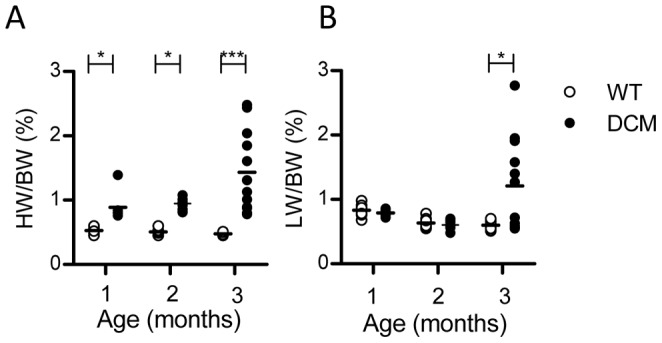
HW/BW and LW/BW ratios in individual WT and DCM mice at 1–3 months of age.
A. HW/BW ratio. B. LW/BW ratio. Bars indicate means. n = 7–12. *P<0.05, ***P<0.001 vs. age-matched WT.